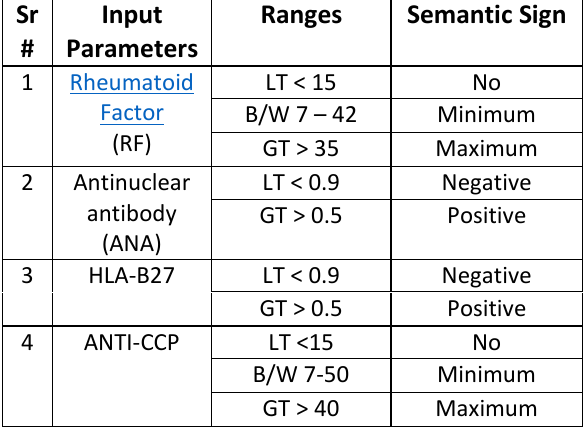
Table 1. Layer-I input variables with medical ranges of proposed DA-AH-MFES expert system